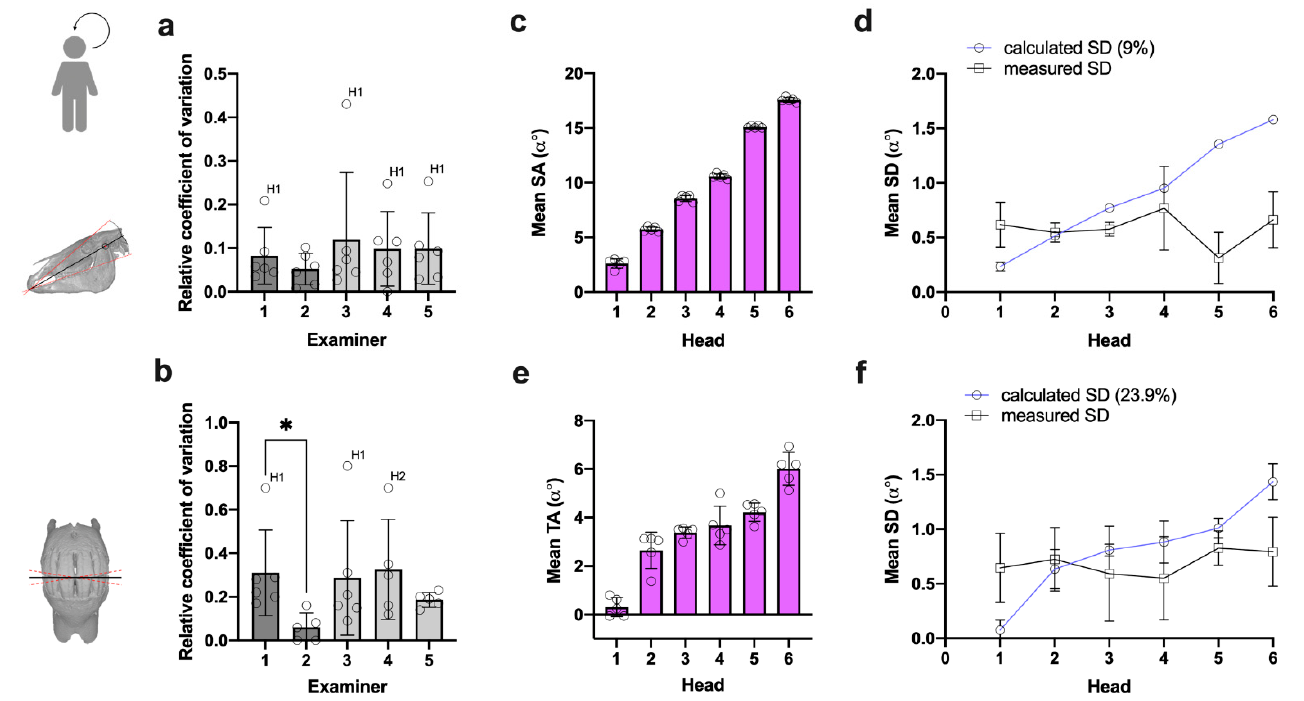
Figure 6. Analysis of SA and TA measurement repeatability. ( a , b ) Mean relative SA and TA COV per examiner (dots = mean for individual heads); ( a ) SA: n = 16(15) measures per head; Kruskal–Wallis test, P = 0.837. ( b ) TA: n = 16(13, head 1) measures per head; Kruskal–Wallis test, P = 0.025; Dunn’s multiple comparisons, * P = 0.021. ( c , e ) Heads ranked after mean SA magnitude (dots = mean for individual examiner) to analyze ( d , f ) scale-level independency of measurement dispersion; ( d ) SA: n = 16(15) measurements per head*examiner; linear regression analysis, calculated SD: P < 0.0001 ( R 2 = 0.990), measured SD: P = 0.766 ( R 2 = 0.003). ( f ) TA: n = 16(15) measurements per head*examiner; linear regression analysis, calculated SD: P < 0.0001 ( R 2 = 0.832), measured SD: P = 0.403 ( R 2 = 0.034).